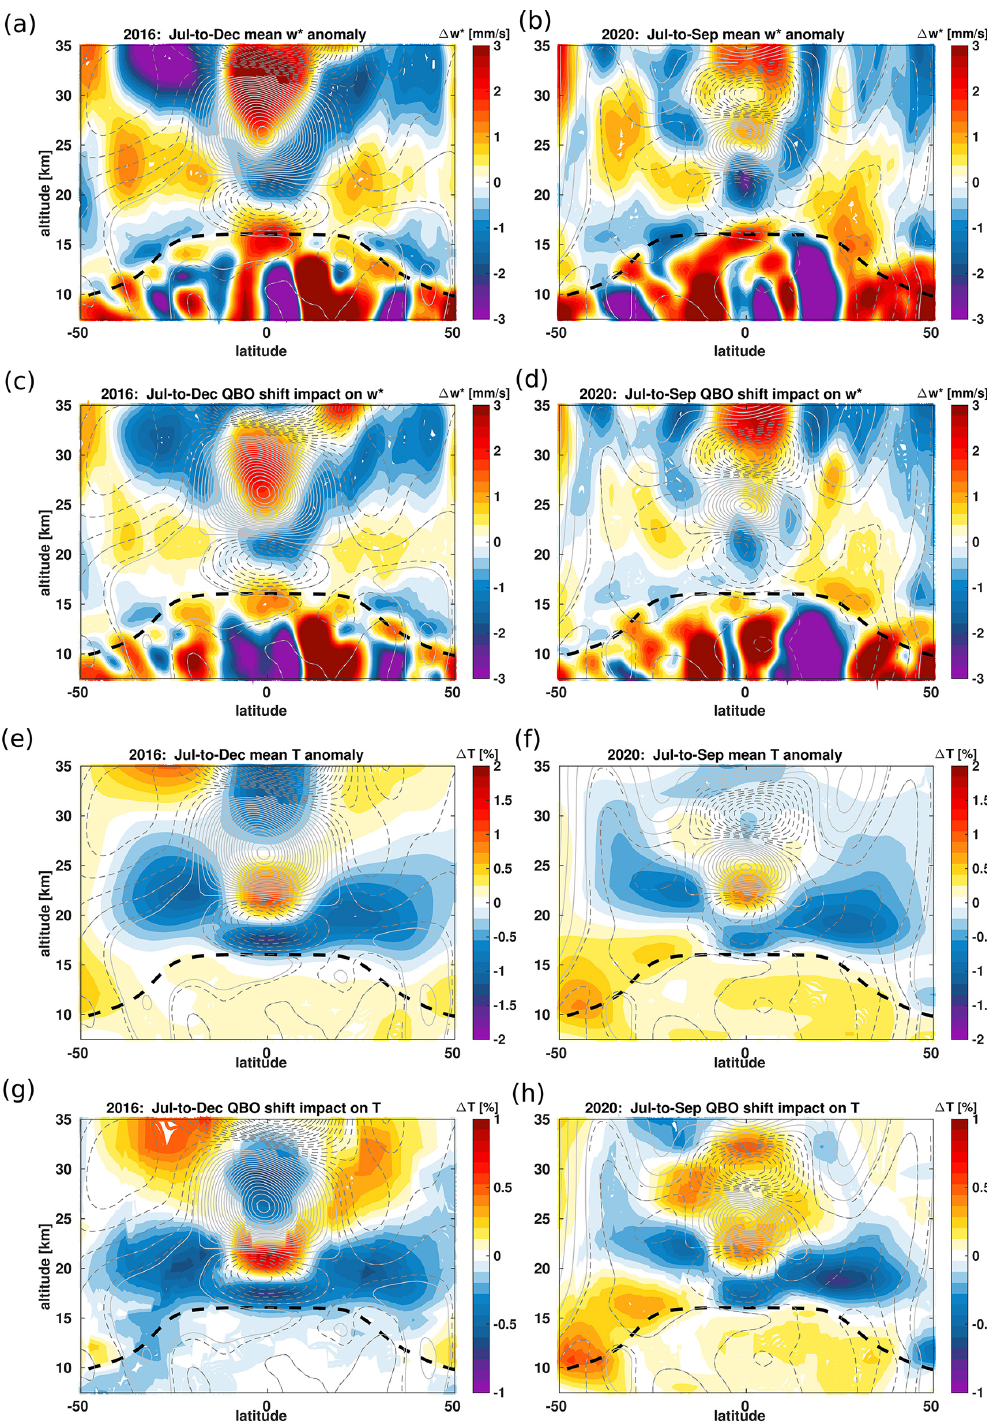
Figure 5. Zonal mean residual vertical velocity ( w ∗ ) (a, b) and temperature anomalies (e, f) from the ERA5 reanalysis together with the impact of QBO disruption events on w ∗ (c, d) and temperature anomalies (g, h) derived from the multiple regression fit for the years 2016 (a, c, e, g) and 2020 (b, d, f, h) . The anomalies are as a deviation from the 2005–2014 zonal mean w ∗ and temperature. The black dashed horizontal line indicates the tropopause from the ERA5 reanalysis. The monthly mean, zonal mean wind component, U (ms − 1 ), from the ERA5 reanalysis is overlaid as solid grey contours (westerly) and dashed grey contours (easterly).